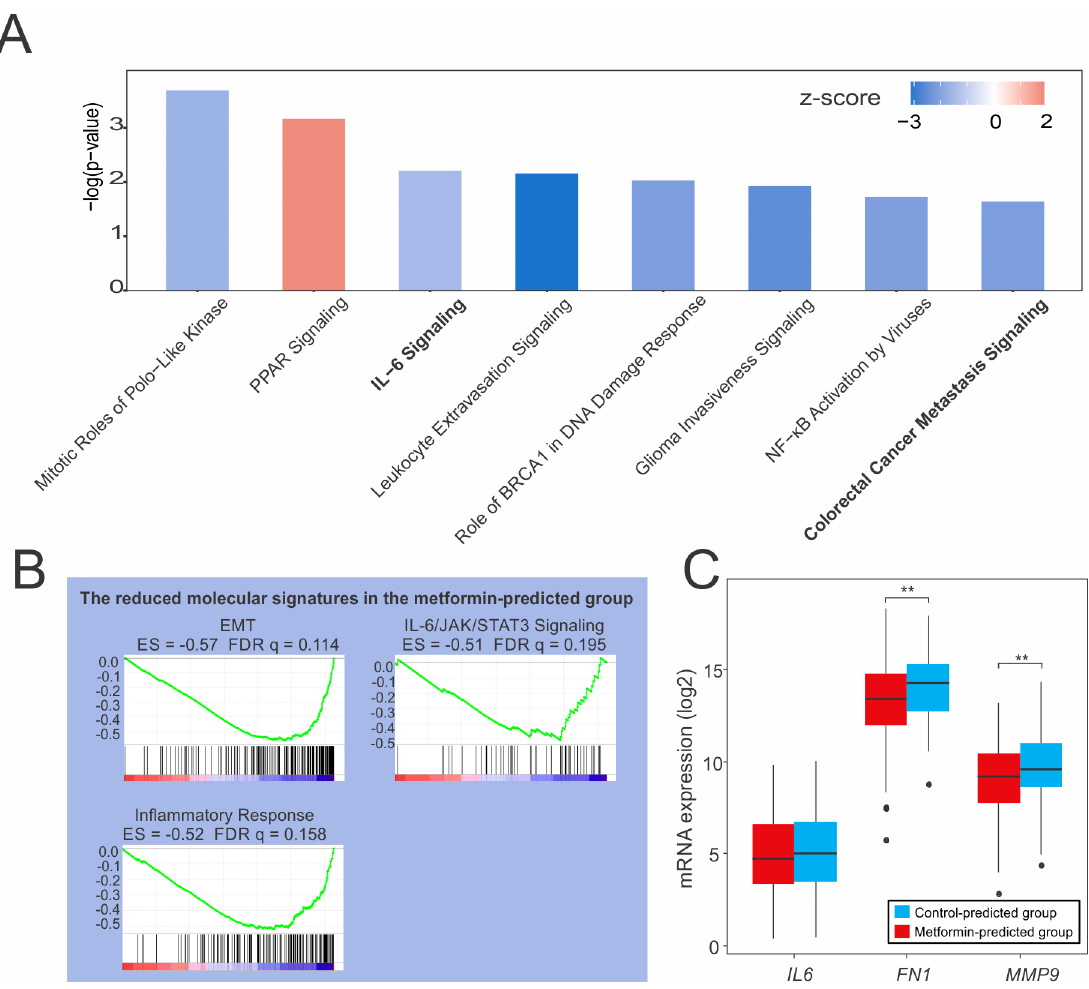
Fig 2. Pathway analysis of TCGA patients. ( A) Canonical pathways in TCGA colon cancer patients as assessed by IPA. IL-6 and colorectal metastasis signaling were decreased. (B) GSEA showed that EMT and IL-6 signaling were reduced in the metformin-predicted group significantly. (C) mRNA expression of IL6 , FN1 ,and MMP9 was decreased in the metformin-predicted group (TCGA dataset). (cid:3) p < 0.05, (cid:3)(cid:3) p < 0.01, JAK: Janus kinase, ES: enrichment score, FDR: false discovery